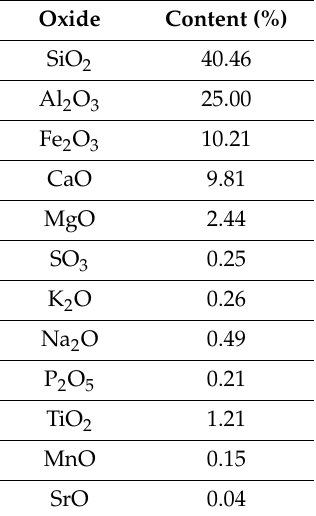
Table 3. The oxide composition of